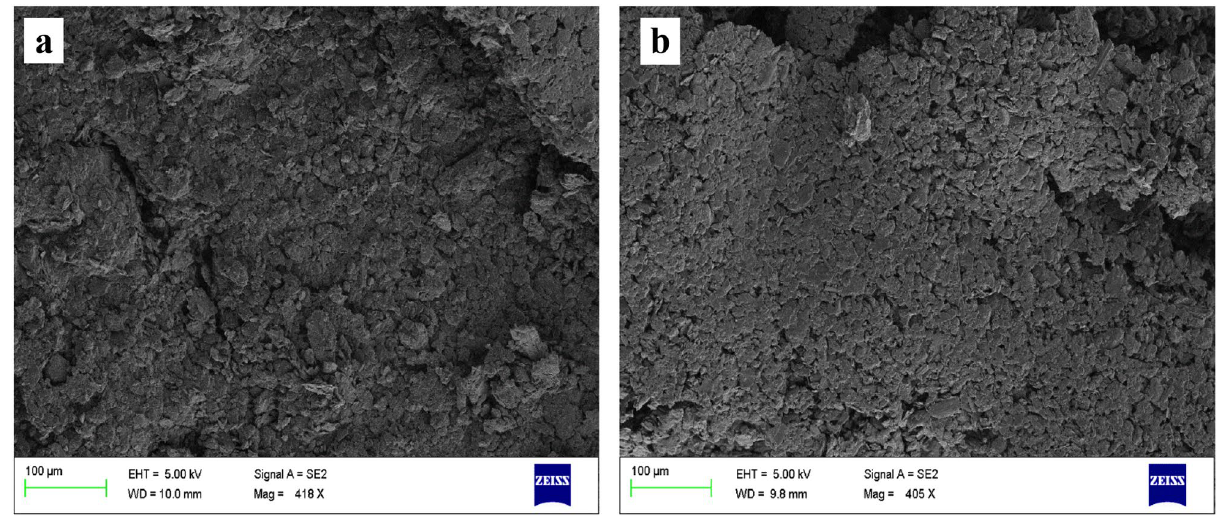
Figure 3. SEM pictures for BCPE ( a ) and poly (CBBG)/MCPE ( b